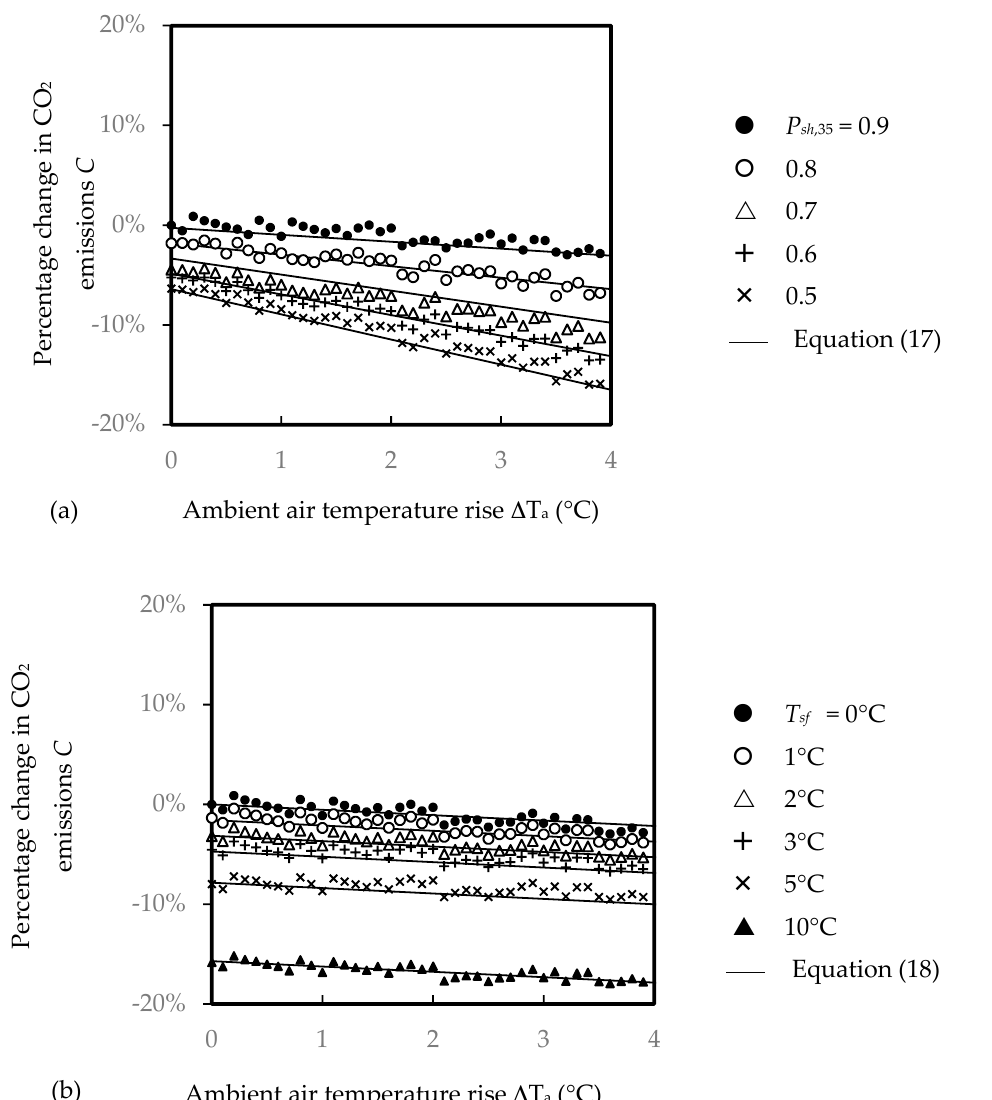
Figure 5. Percentage change in CO 2 emissions against ambient air temperature rise: ( a ) Behavioural responses related to taking fewer hot showers; ( b ) Behavioural responses to a positive temperature shift.